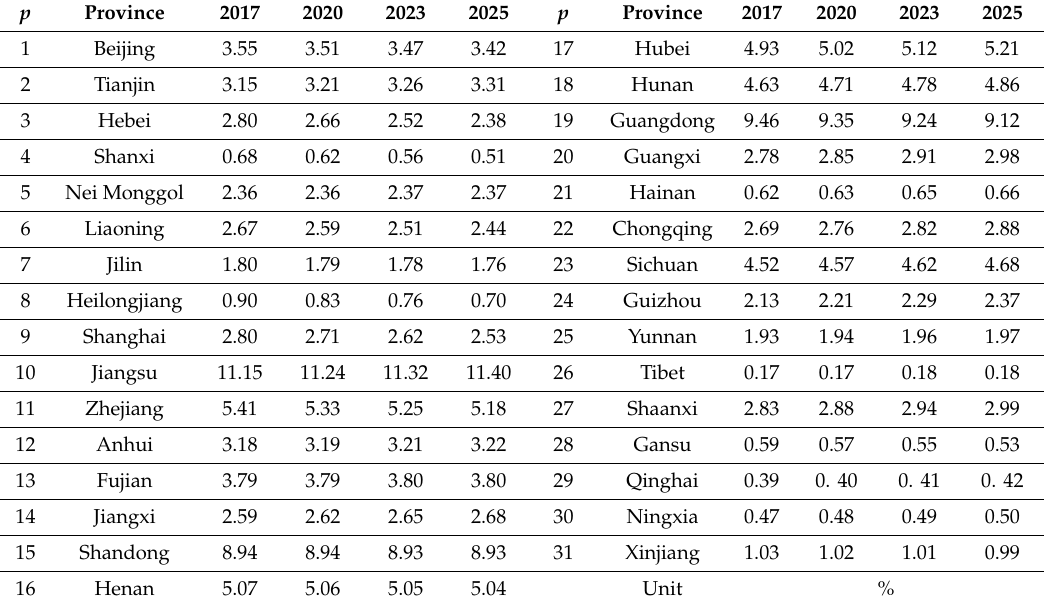
Table 2. Predicted regional contribution rate to national economy in 2017, 2020, 2023, and 2025.